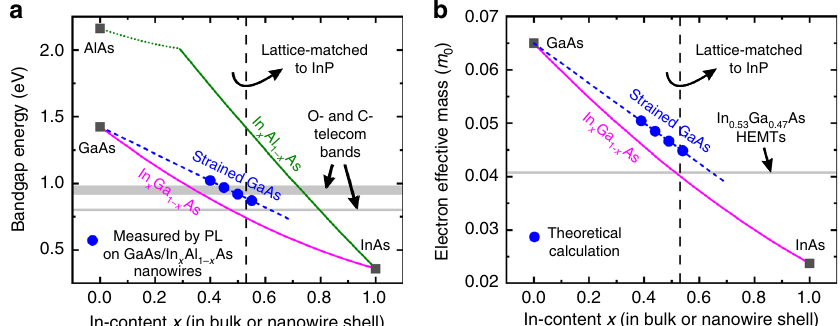
Fig. 6 Comparison of electronic properties at the Γ -point of the Brillouin zone, at 300 K, between strained GaAs in GaAs/In x Al 1 − x As core/shell nanowires (our results) and strain-free III-As ternary alloys (ref. 1 ), as a function of In-content x in the shell or the bulk. a Bandgap energy. The values for strained GaAs (blue data points) are the ones for E 1 measured by photoluminescence (PL) at 300 K in Fig. 5a. The blue dashed line is a linear fi t. The magenta and green curves correspond to strain-free In x Ga 1 − x As and strain-free In x Al 1 − x As, respectively. b Electron effective mass. The values for strained GaAs (blue data points) were calculated using Eqs. (3), (4) and (5). The blue dashed line is a linear fi t. The magenta curve corresponds to strain-free In x Ga 1 − x As. The grey bands in ( a , b ) indicate regimes relevant to speci fi c device applications (telecom photonics and high electron mobility transistors-HEMTs), where typically In x Ga 1 − x As thin fi lms with x = 0.53 (indicated with a vertical dashed line) are employed because they are lattice-matched to commercial